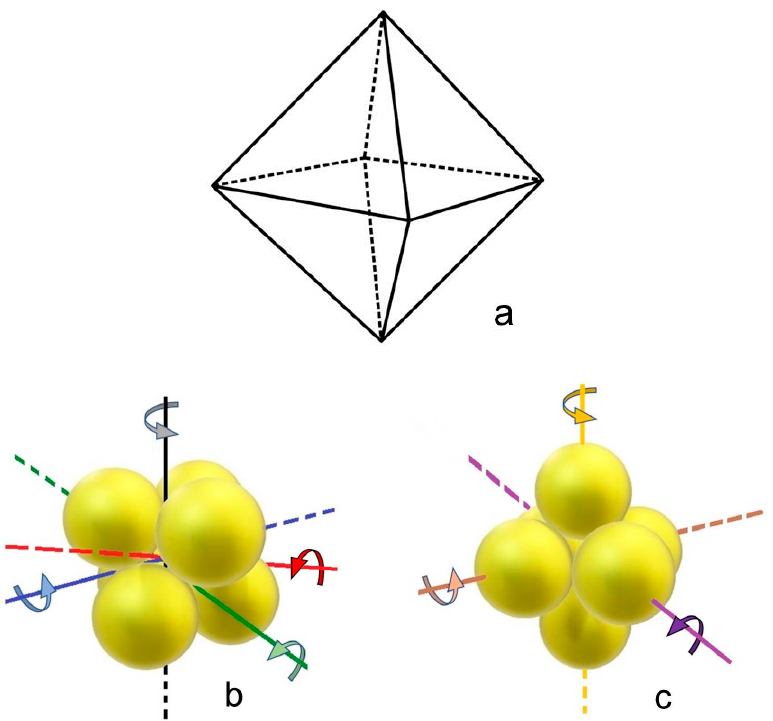
Figure 3. Schematic of the RLM structure of the triangular octahedron model ( a ) for the deuteron, drawn using the de Broglie–Compton wavelength spheres of the rotating neutrinos ( b , c ) each of radius r = 0.631 fm = (cid:125) / γ m o c and showing the seven rotational axes, of which four are equatorial type ( b ) and three are top–bottom type ( c ).